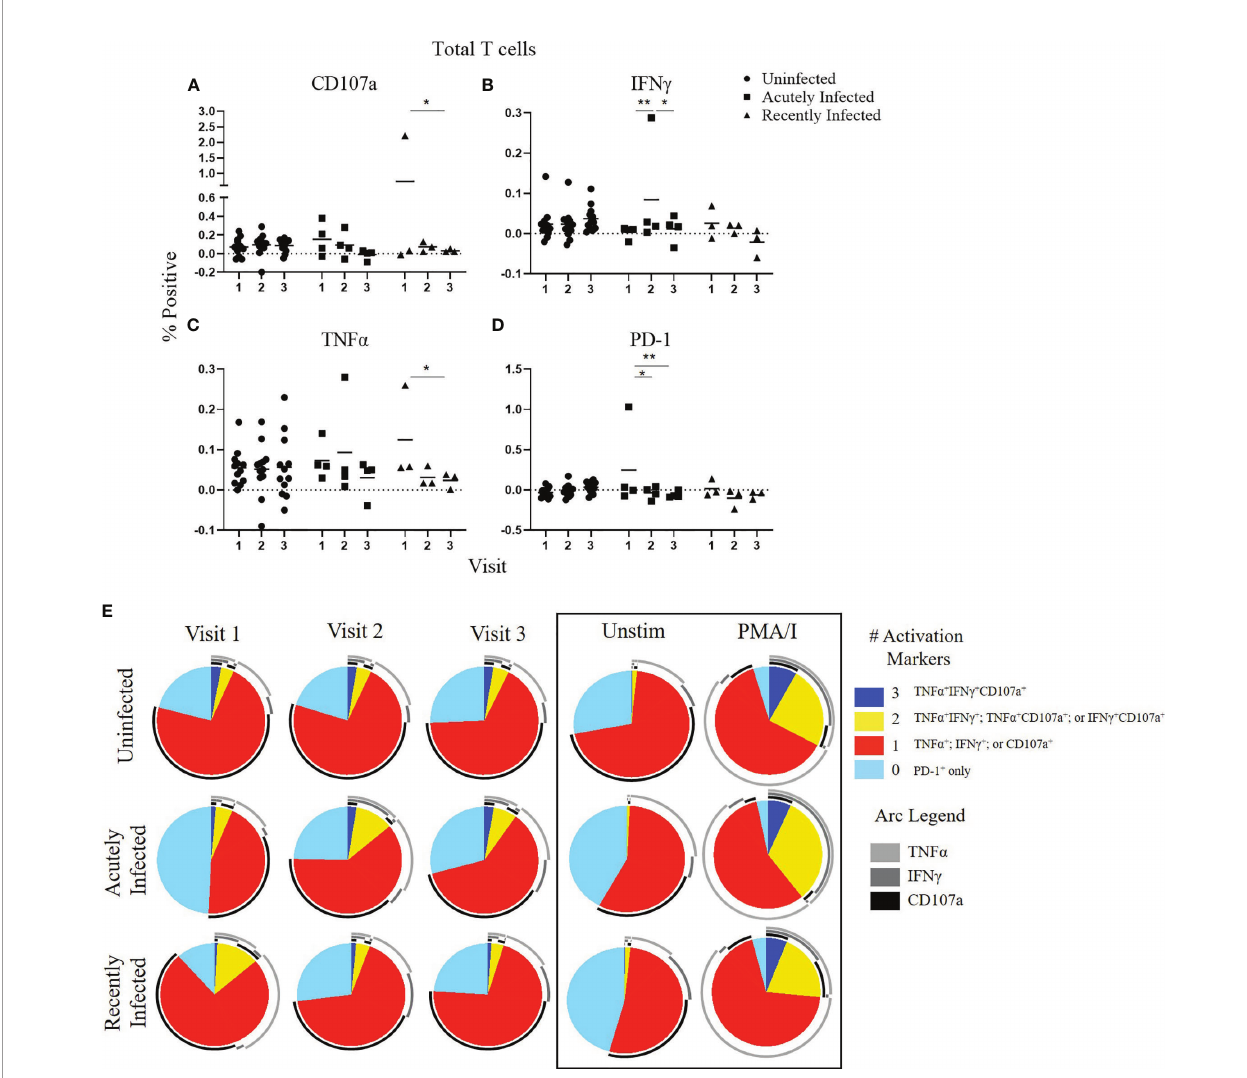
FIGURE 1 | Total T cell responses to the RSV F protein peptide libraries as a function of RSV infection status and study visit. (A – D) Individual functional marker expression following stimulation with the RSV/A F (RSV F A ) protein peptide library by RSV infection status: uninfected ( n = 12), acutely infected ( n = 4), and recently infected ( n = 3). PBMCs from adult volunteers were stimulated with the RSV F A protein peptide library and the expression of CD107a, IFN g , TNF a , and PD-1 were measured relative to the unstimulated controls by fl ow cytometry. These values are reported as percent positive of total CD3 + T cells. Each symbol represents the response from a single individual. The thick horizontal bar indicates the mean of all responses within each group at that visit. A signi fi cant pairwise comparison of mean percentage difference between visits within a group is denoted by a thin horizontal bar with * P ≤ 0.05, ** P ≤ 0.01. (E) Polyfunctional T cell responses to RSV F A protein peptide library by RSV infection status. Simpli fi ed Presentation of Incredibly Complex Evaluations (SPICE) software was used for the identi fi cation of total T cells expressing the various activation markers. Pie charts show the frequency in which PBMCs produced the various combinations of the activation markers CD107a, IFN g , and TNF a ; or expressed PD-1 alone. Background (determined from the media-stimulated negative controls) was subtracted from all samples and negative values were set to zero. Surrounding arcs denote the speci fi c markers produced by the cells in each pie segment. Representative negative and positive controls across all study visits are